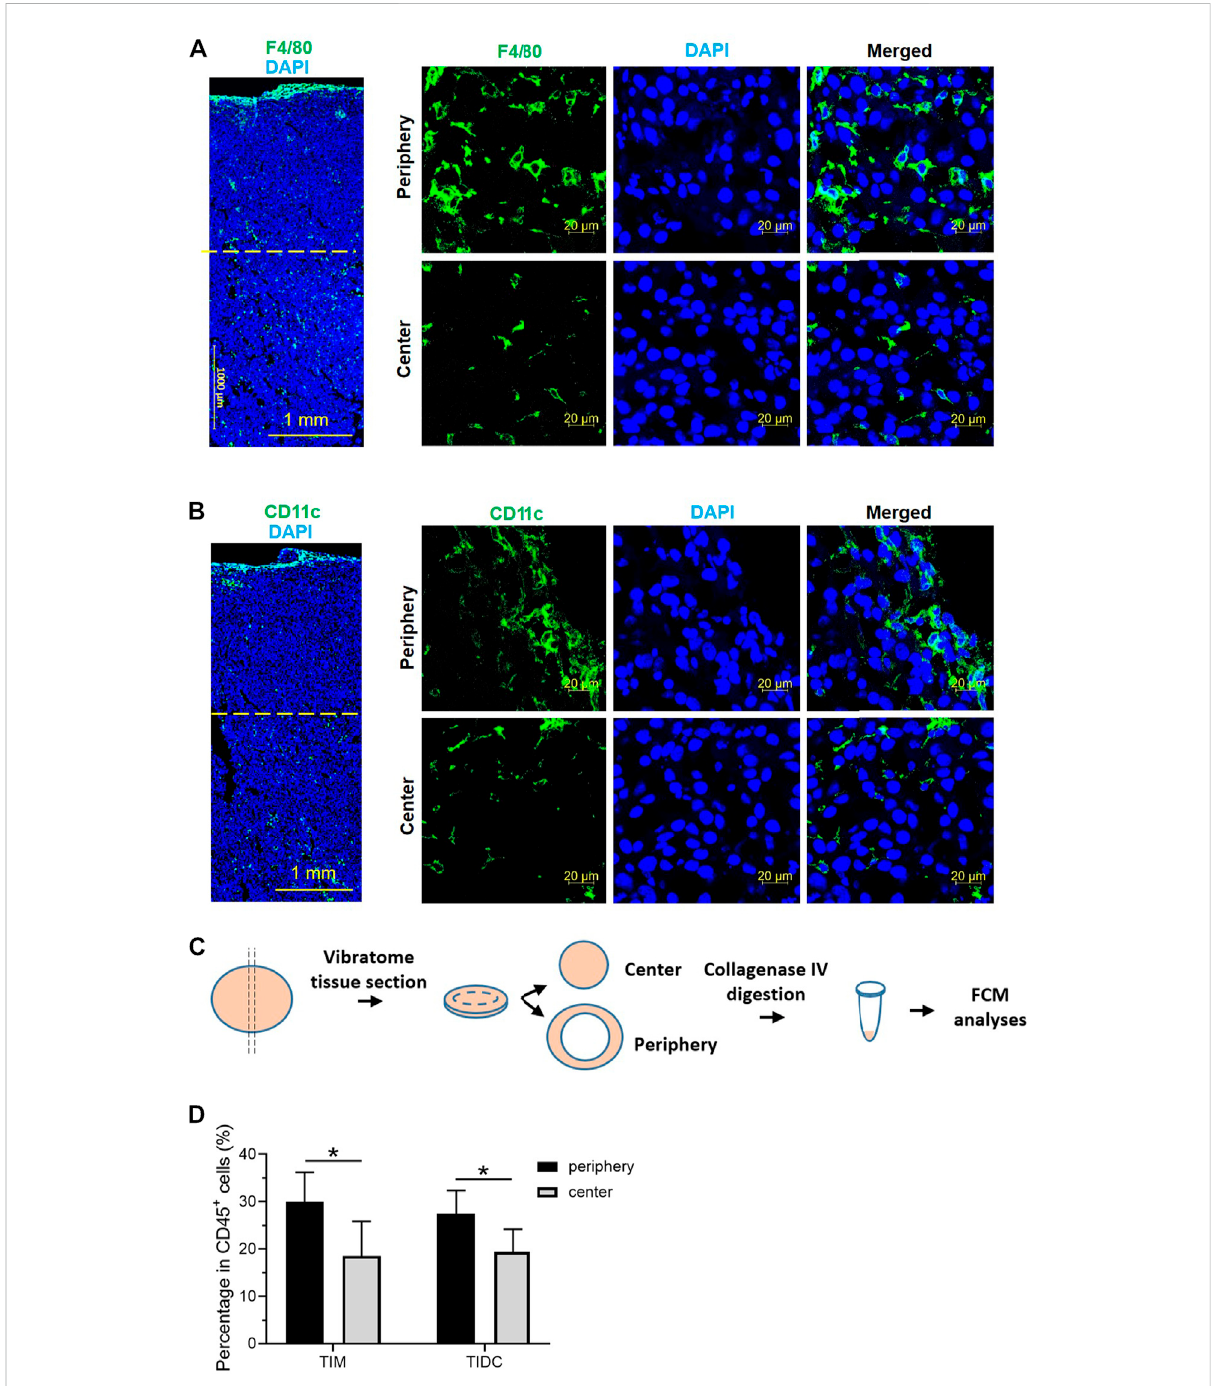
FIGURE 1 The tumor-in fi ltrating macrophages and DCs mostly distributed in the tumor periphery. (A,B) Confocal laser scanning microscopy (CLSM) images showed the distribution of macrophages (A) or dendritic cells (B) in B16 tumor tissue 14 days after subcutaneous tumor inoculation. The macrophages were stained with PE labeled anti-F4/80 antibody (green). The DCs were stained with APC labeled anti-CD11c antibody (green). The nuclei were stained with DAPI (blue). Scale bar, 1,000 μ m (Large area image) or 20 μ m (peripheral region and central region). (C) Schematic illustrations of vibratome tissue section and separation of B16 tumors into peripheral and central part. The tumor tissue was digested and fl ow cytometry was used to assess the tumor-in fi ltrating immune cells. (D) The frequency of tumor-in fi ltrating macrophages and DCs in CD45 + cells in the peripheral and central region of B16 tumor 14 days after subcutaneous tumor inoculation. Data are presented as mean ± SD ( n = 5 per group). * p <